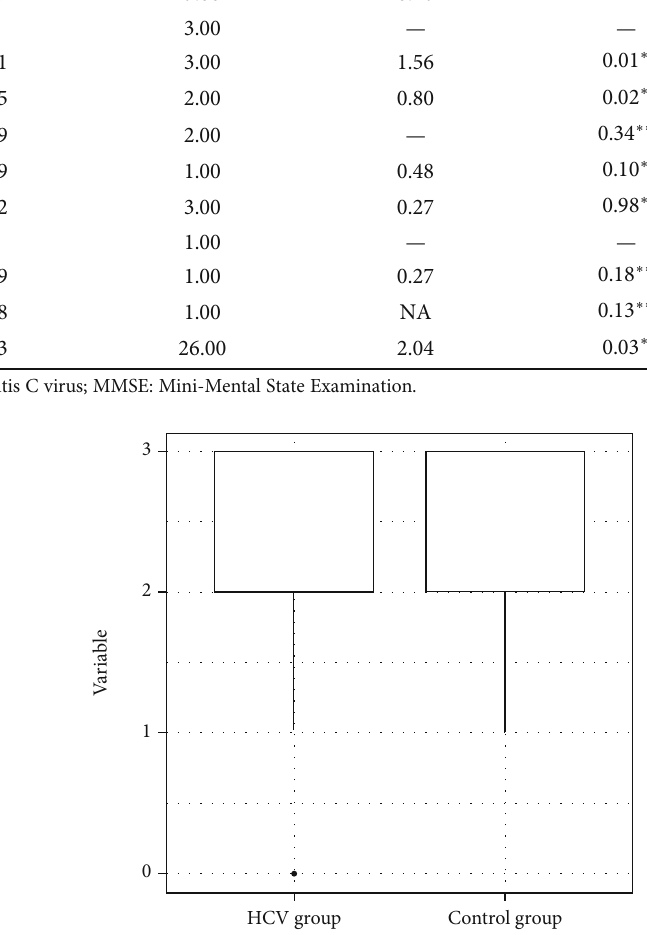
Figure 2: Distribution of the variable Mini-Mental State Examination attention and calculation scores.